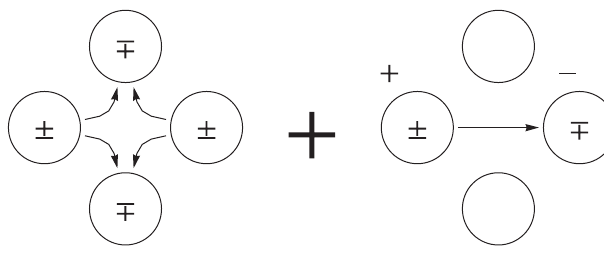
FIG. 2. rf voltages applied to the quadrupole electrodes of the LPT. In addition to the regular rf power of quadrupole symmetry (left), we simultaneously introduce the dipole rf perturbation (right) to excite integer